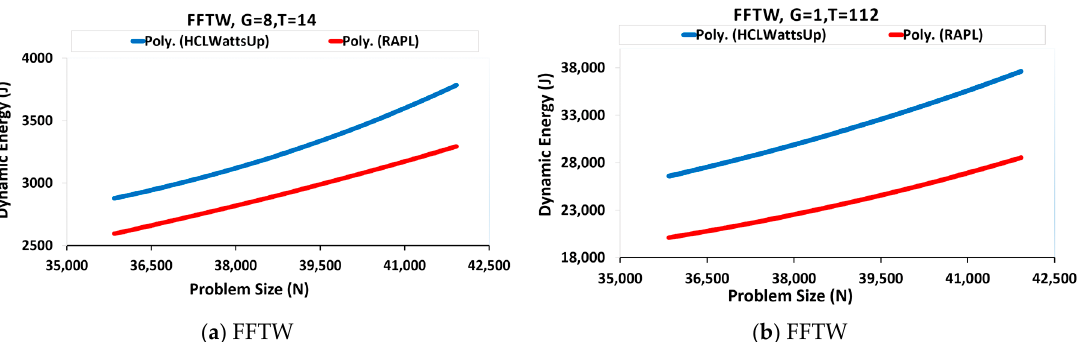
Figure 6. Group B (sets of single energy profile), class similar similarity. Here, G = CPU thread groups, and T = CPU threads.